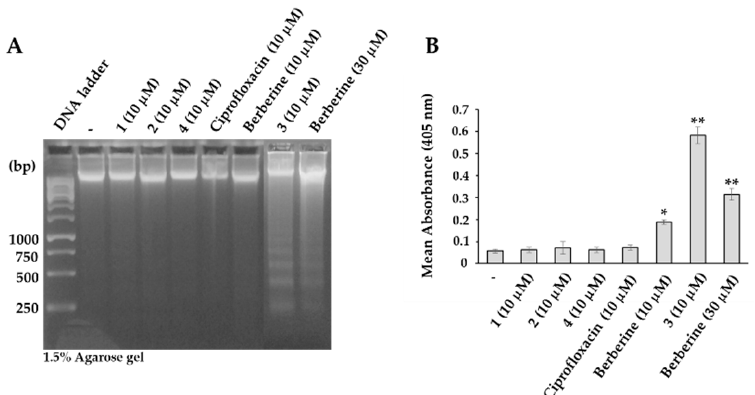
Figure 6. ( A ) Detection of apoptotic DNA fragmentation in HL-60 cells treated with indicated concentrations of berberine, ciprofloxacin and berberine derivatives for 48 h. ( B ) Activation of caspase-3 expressed as the mean absorbance at 405 nm (the relative amount of the pNA released from the DEVD-pNA). Each point represents a mean ± S.D. from 3 independent experiments. * p < 0.05, ** p < 0.01.